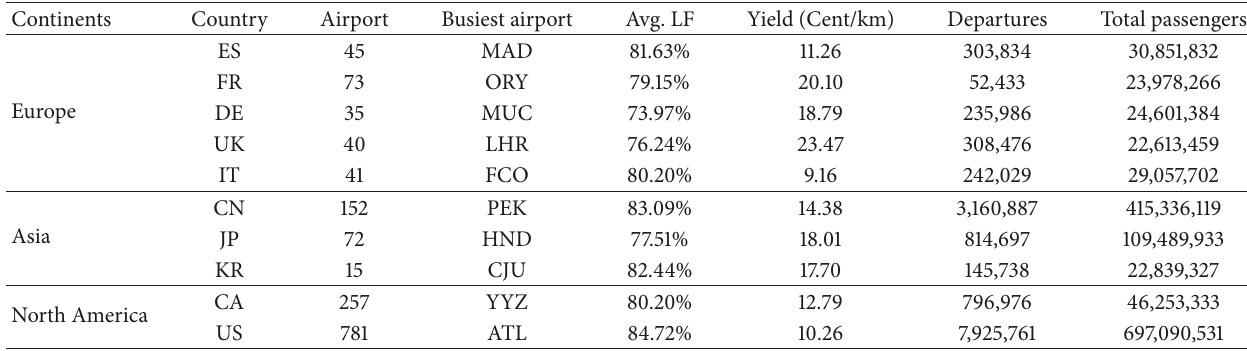
Table 1: Overview of the domestic air transport in five countries in Europe, three countries in Asia, and two countries in North America for the year 2015. Note that the busiest airport is ranked according to the number of domestic passengers. Data source: Sabre Airline Solutions (https://www.sabreairlinesolutions.com/). The abbreviation LF stands for load factor.